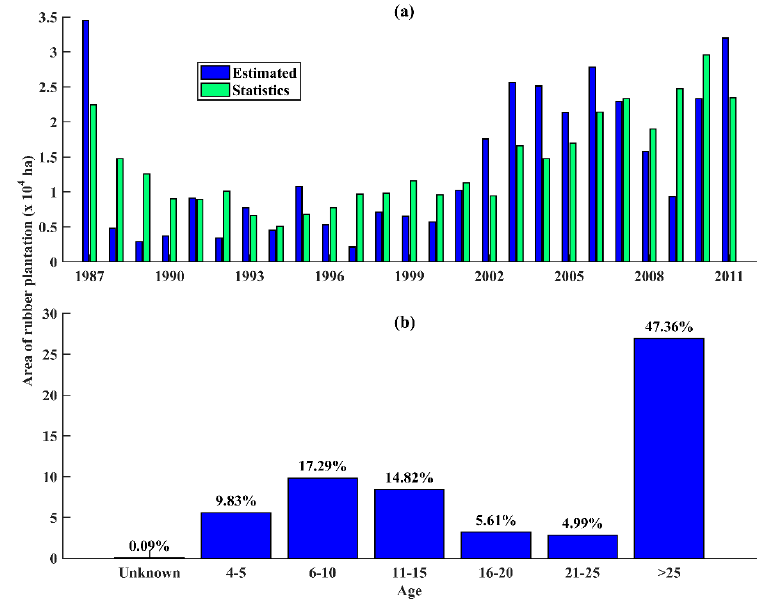
Figure 8 . Statistical information on establishment year of rubber plantations in 2015: ( a ) the annual area of rubber plantations from our map (estimated) against agriculture census (statistics) since 1987, and ( b ) the age structure of rubber plantations in 2015 on Hainan Island presented in area and percent mode.